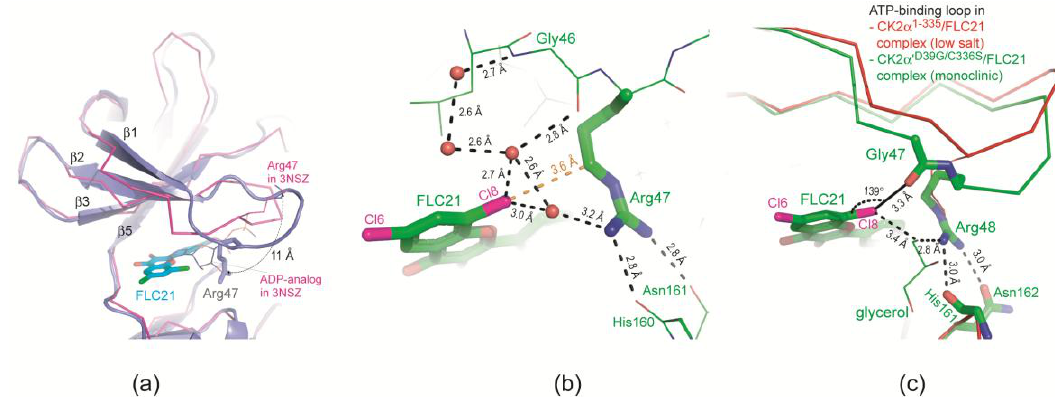
Figure 4. Arg47/48 and FLC21 stabilize a non-functional conformation of the ATP-binding loop. ( a ) The N -terminal domain of the low-salt CK2α 1–335 /FLC21 complex (purple; structure 3 in Table 1) and for comparison (in order to illustrate the functional state of the ATP-binding loop) of PDB-file 3NSZ which contains human CK2α 2–331 in complex with an ADP-analog [37]; ( b ) More detailed and focused view of the low-salt CK2α 1–335 /FLC21 complex in which the hydrogen-bonds of Gly46, Arg47 and the Cl8-atom of FLC21 are highlighted. The nearest atomic distance between FLC21 and Arg47 is indicated in orange colour. Four water molecules are drawn as red balls; ( c ) the equivalent region in protomer B of the monoclinic CK2α′ Asp39Gly/Cys336Ser /FLC21 complex structure (No. 2 in Table 1). For comparison the ATP-binding loop plus Arg47 side chain of the low-salt CK2α 1–335 /FLC21 complex (structure 3 in Table 1) is drawn in red colour. Note that due to a one residue insertion near the N -terminus the sequence numbers in human CK2α′ are shifted by +1 compared to human CK2α.